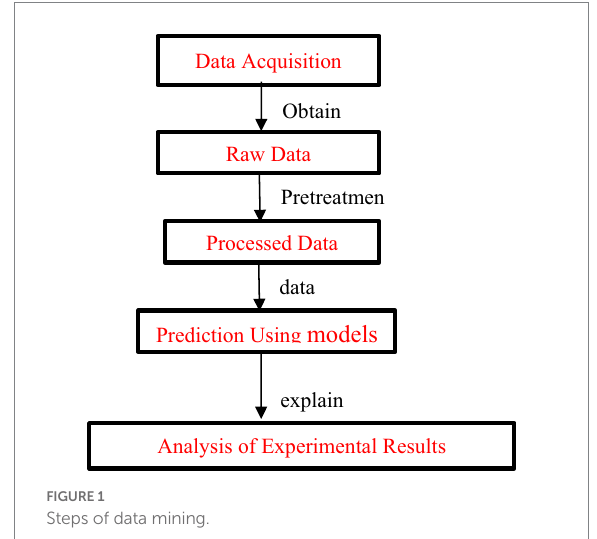
FIGURE 1 Steps of data